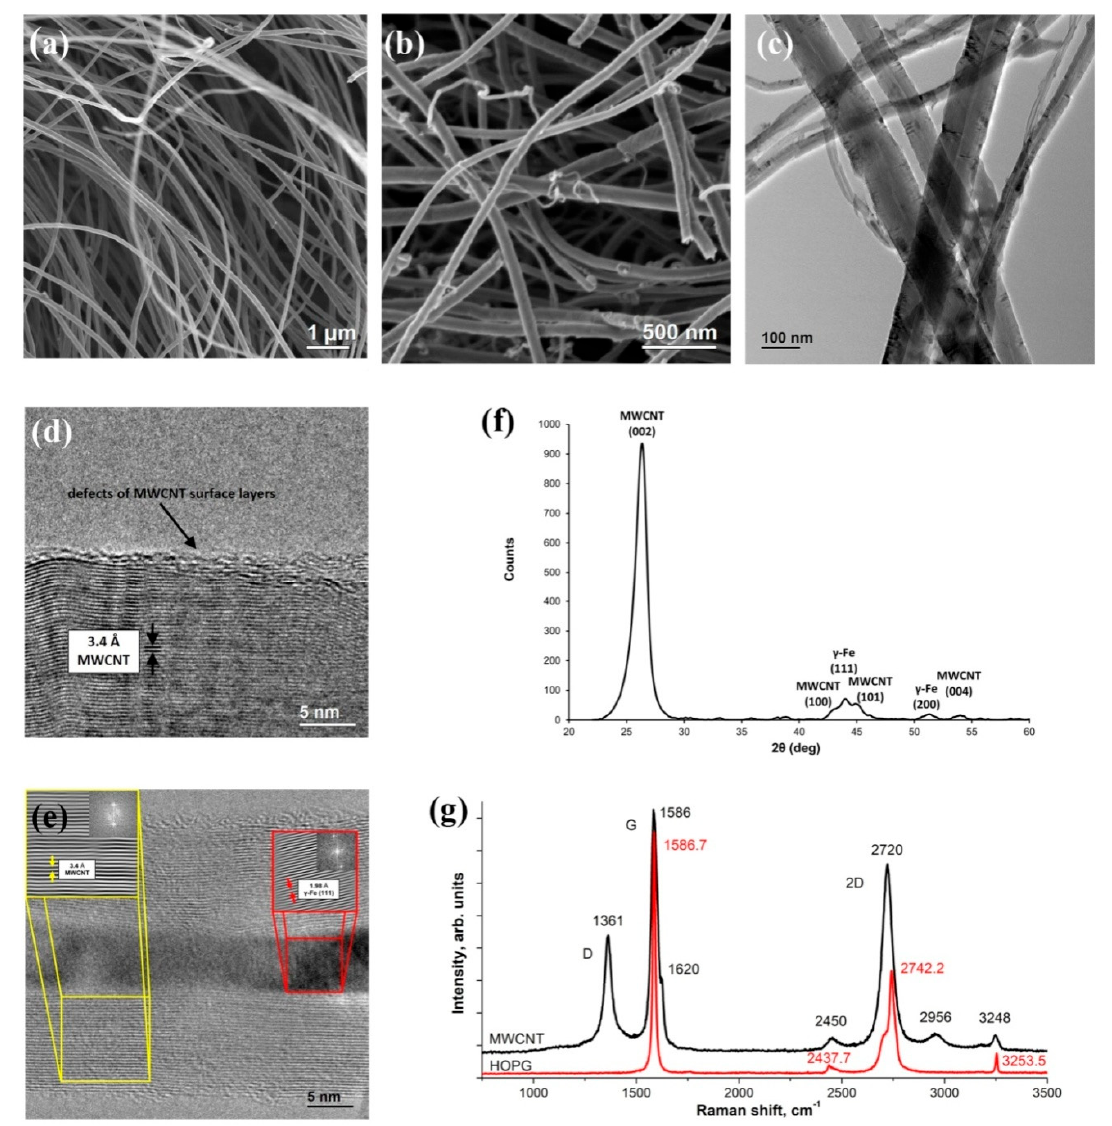
Figure 2. The initial MWCNTs research results: ( a , b ) scanning electron microscope (SEM) images of initial MWCNTs; ( c ) transmission electron microscope (TEM) image of MWCNTs; (d , e) high-resolution TEM (HRTEM) images of a γ -Fe-filled nanotube with inserts of FFT (fast Fourier transform) which show the carbon interplanar spacing 0.34 nm and the crystallinity of the filling ( γ -Fe interplanar spacing 0.198 nm); ( f ) X-ray powder diffraction pattern of initial MWCNTs; ( g ) Raman spectra of MWCNT and HOPG.